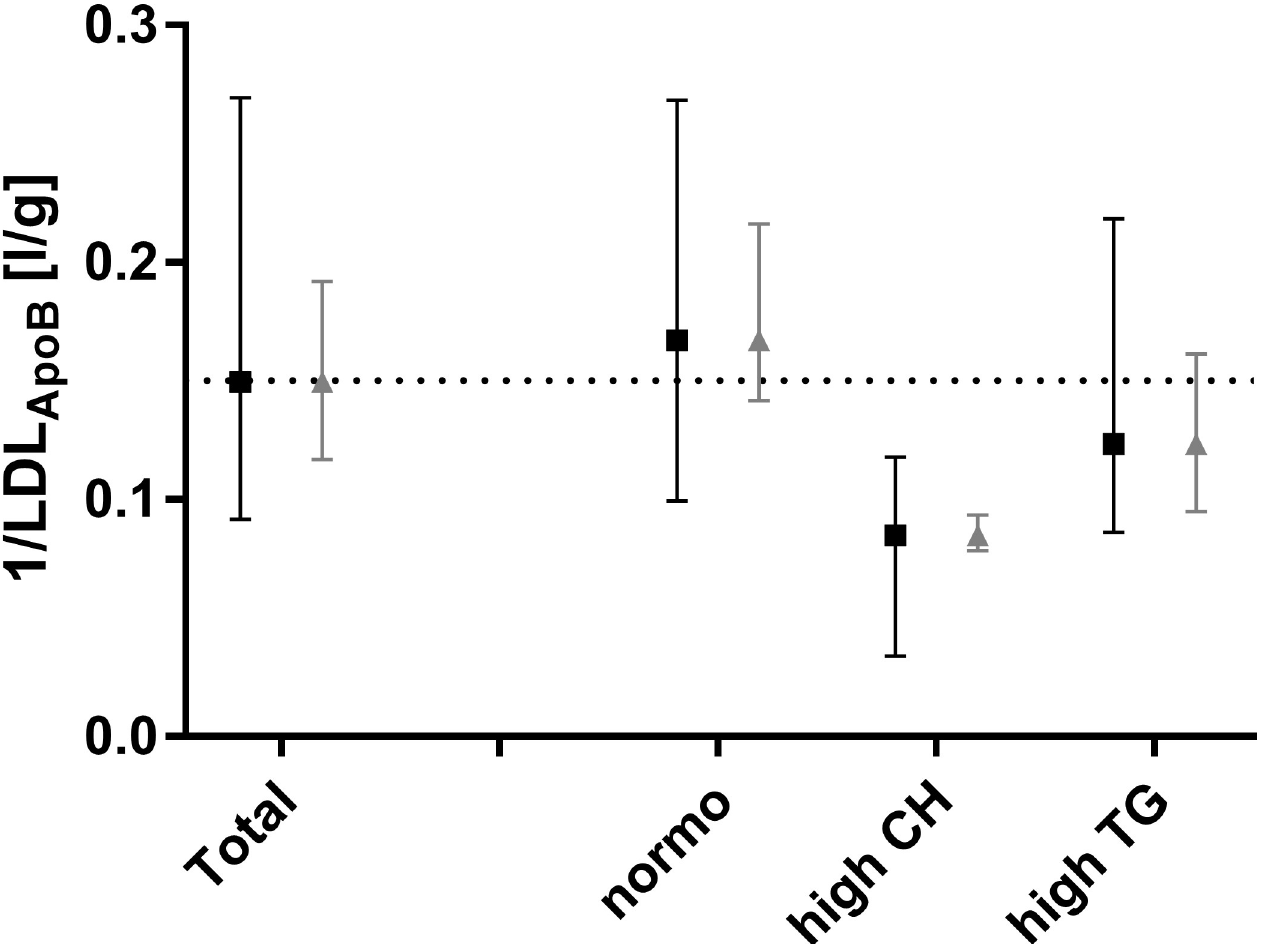
Fig 4. LDL-FCR estimation. Quartiles of the FCR estimator 1/ LDL median (dotted line) of 1/ LDL